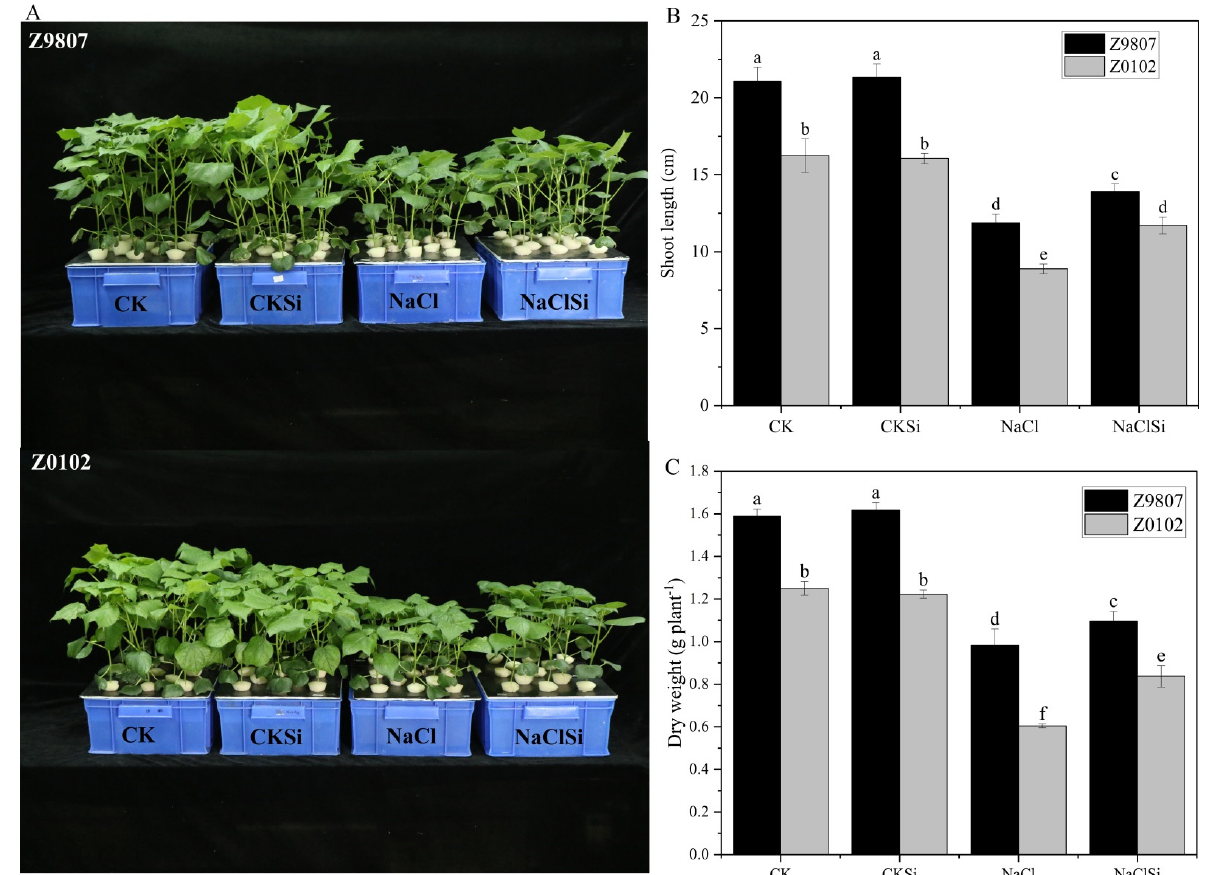
Figure 1. Effects of Si on cotton growth ( A ), shoot length ( B ), and biomass accumulation ( C ) at 14 days after various treatments. Error bars represent the standard error ( n = 3). Different letters mean significantly different among treatments at p ≤ 0.05. Table 1. Effect of exogenous Si on gas-exchange parameters of cotton leaf under saline and non-saline